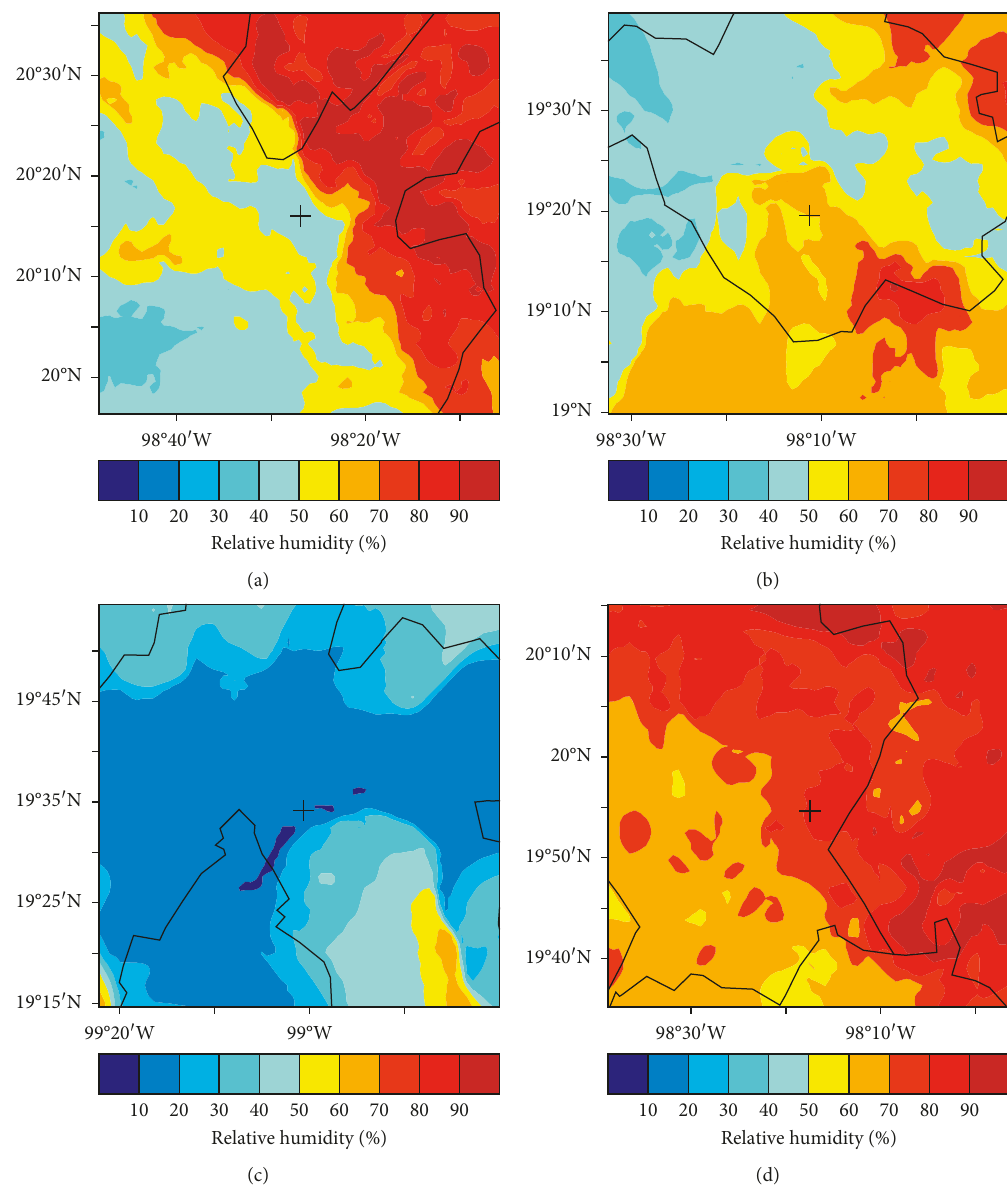
Figure 3: Relative humidity at 2m calculated for anticyclonic tornadoes (a, b) (I.D. 6 and 9, respectively) and cyclonic tornadoes (c and d) (I.D. 15 and I.D. 20, respectively) (Table 1). The black cross indicates the position of the